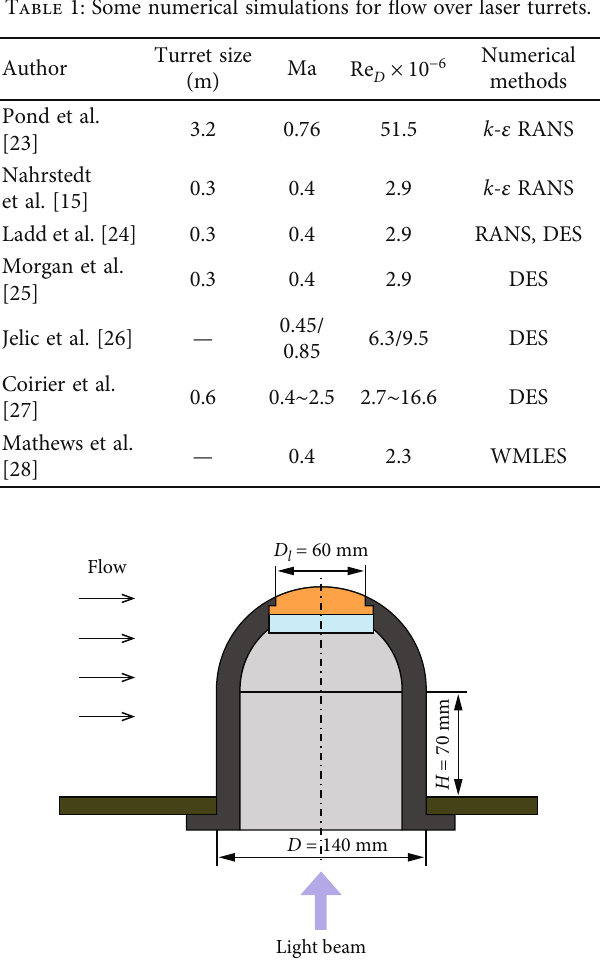
Figure 2: Hemisphere-on-cylinder turret model with a conformal window.